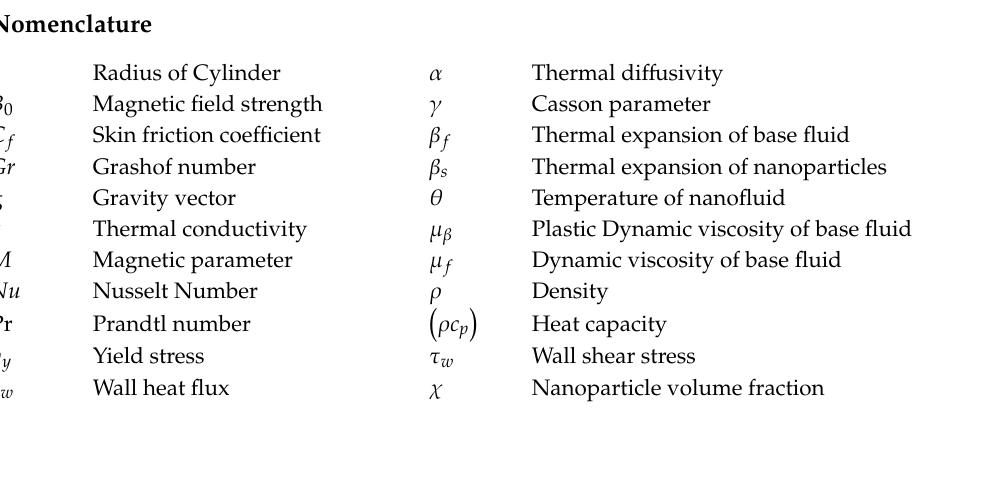
Figure 13. Impact of M on 1/5 Gr Nu